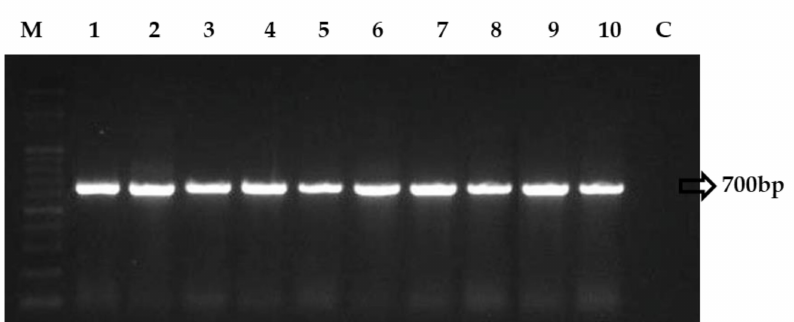
Figure 3. PCR amplification of PMITS region of the isolates of E. pisi.